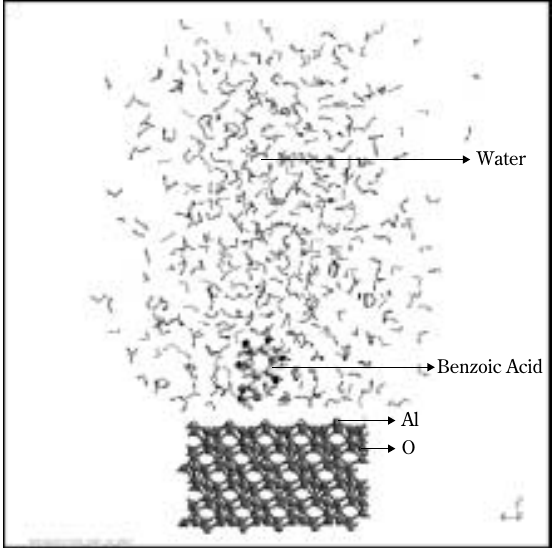
Alumina (001) (cid:2) benzoic acid complex in presence of water optimized by MD